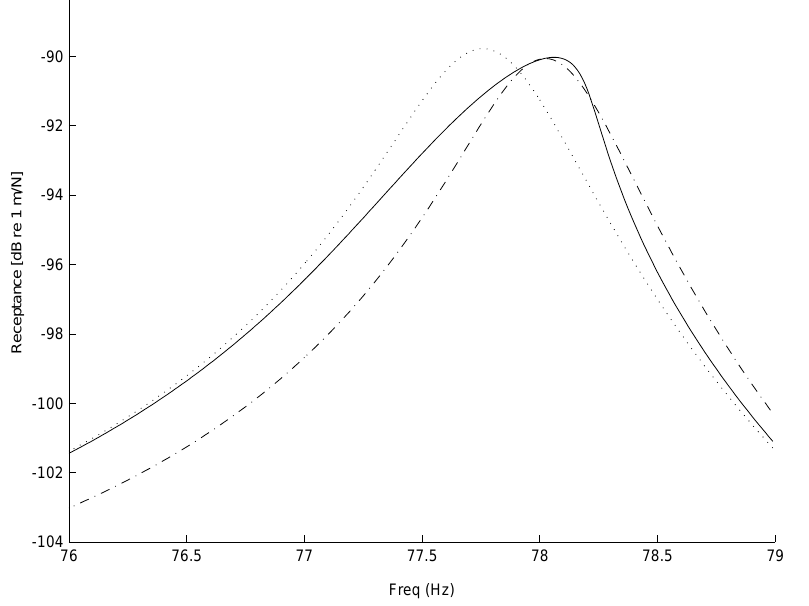
Fig. 5. Linear modal analysis of non-linear response: ... True linear FRF, − . − . − Linearised response through linear modal analysis, True non-linear